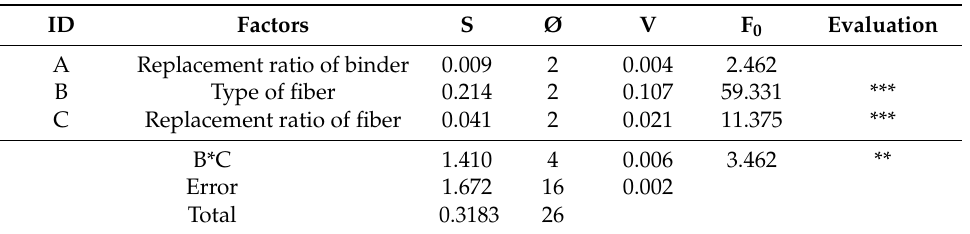
Table 9. Variance analysis for the dry density of the extrusion panel.